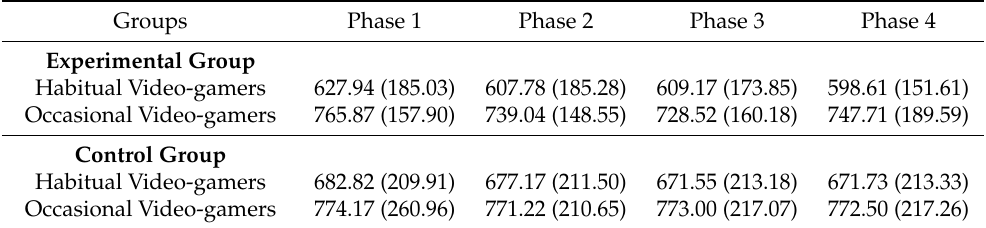
Table A2. Means (and standard deviations) of the RTs in the Auditory Search Task.